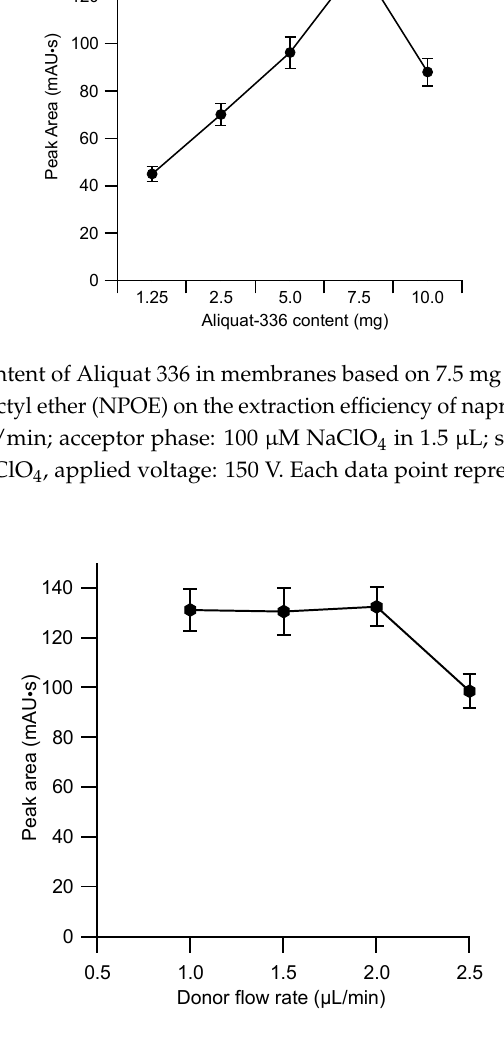
Figure 3. Effect of the content of Aliquat 336 in membranes based on 7.5 mg cellulose triacetate (CTA) and 5 mg o ‐ nitrophenyl octyl ether (NPOE) on the extraction efficiency of naproxen. Donor background: 100 μ M NaClO 4 at 2 μ L/min; acceptor phase: 100 μ M NaClO 4 in 1.5 μ L; standard: 10 μ L of 50 μ M naproxen in 100 μ M NaClO 4 , applied voltage: 150 V. Each data point represents the mean value for five measurements.